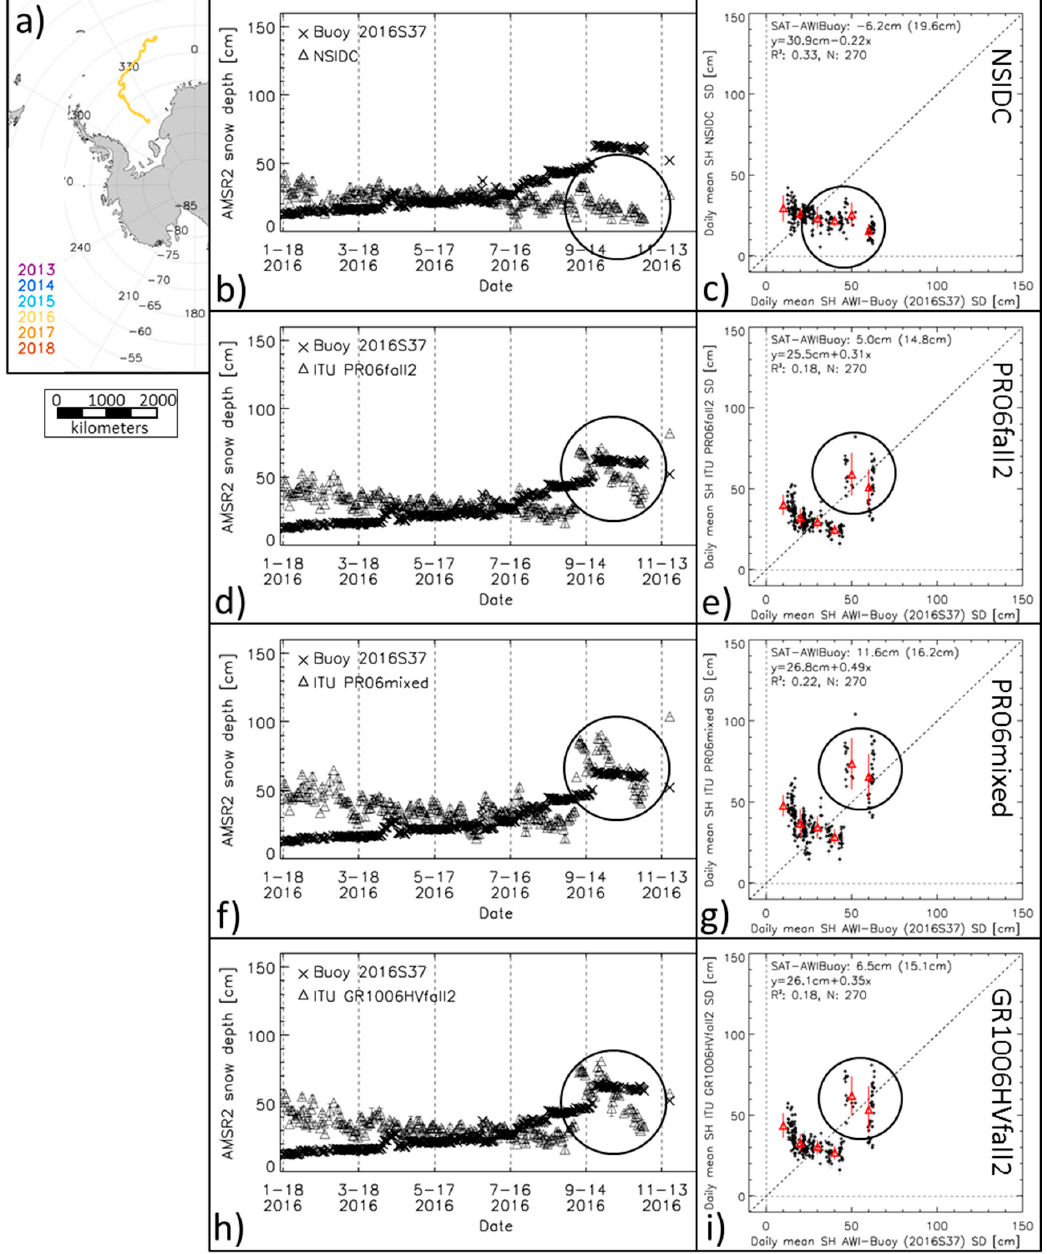
Figure 14. The results of the comparison between the AMSR2 snow depth and the snow depth observed by AWI buoy 2014S37. Panel ( a ) shows a map showing the track of the buoy color-coded according to the year of operation; panels ( b , d , f , h ) show the time series of the buoy (crosses) and NSIDC (triangles) snow depth; panels ( c , e , g , i ) show the scatterplots of the data shown in the time series. For colors and parameters given in the scatterplots, see the caption of Figure 10.